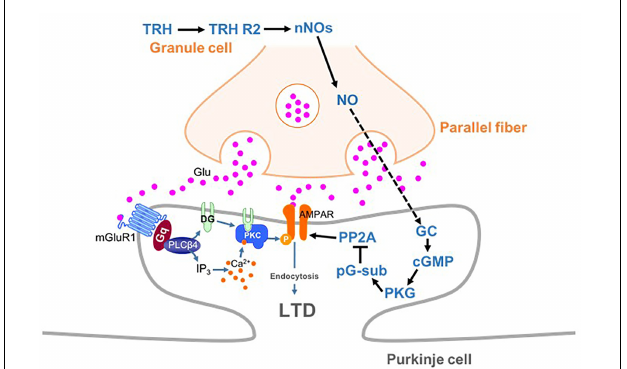
FIGURE 8 | Schema depicting proposed signaling cascades regulating cerebellar LTD. AMPA receptors are phosphorylated by PKC in mGluR1-dependent manner. TRH produces NO in granule cells (and molecular layer interneurons), which diffuses into PCs. NO produces cGMP via activation of the guanylyl cyclase, leading to activation of PKG. Activated PKG phosphorylates G-substrate, which in turn suppresses PP2A. Since PP2A counteracts PKC in terms of AMPA receptor phosphorylation, suppression of PP2A facilitates LTD through enhancement of AMPA receptor phosphorylation. cGMP, cyclic guanosine monophosphate; GC, guanylyl cyclase; LTD, long-term depression; nNOs, neuronal NO synthase; pG-sub, phosphor-G-substrate; PP2A, protein phosphatase 2A; PKG, cGMP-dependent protein kinase G; TRH, thyrotropin-releasing hormone; TRH R2, TRH receptor